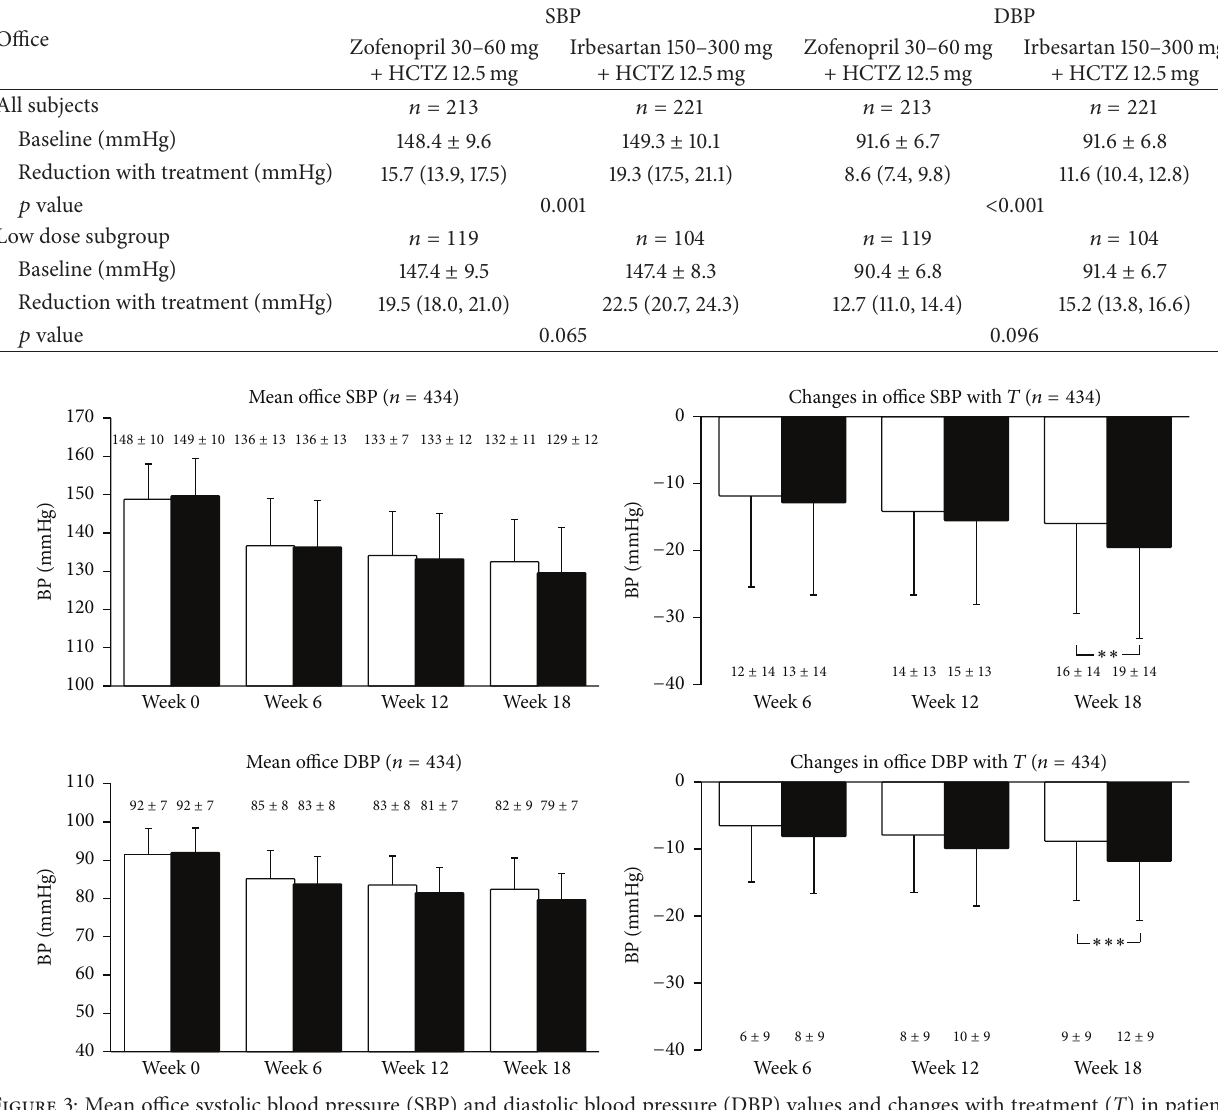
4 were definitely withdrawn from the extension phase (3 zofenopril versus 1 irbesartan, 𝑝 = 0.368